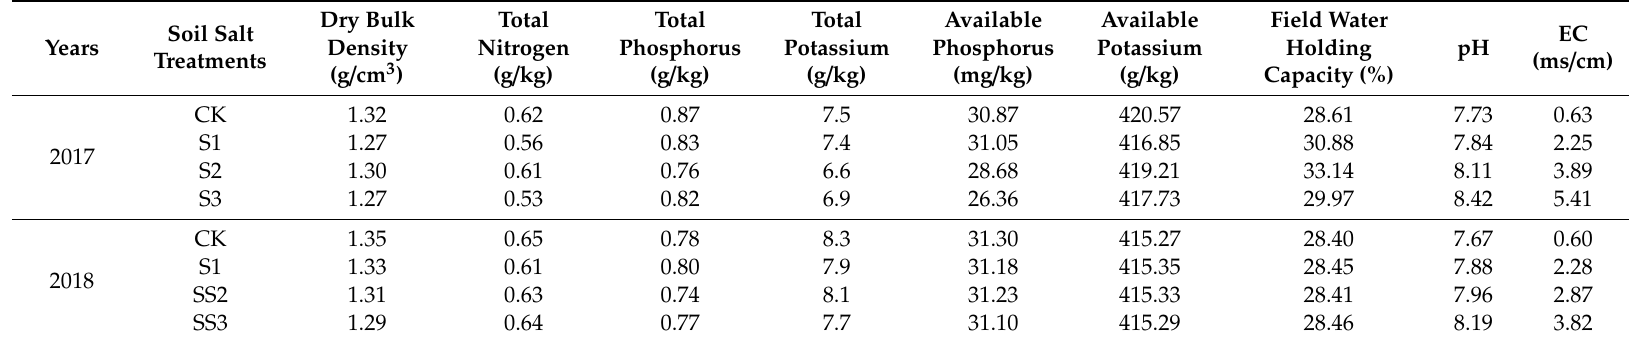
Table 1. Soil (0–40 cm) properties at the study site.